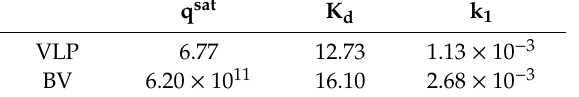
Table 1. Best-fit values of the kinetic form of the Langmuir adsorption isotherm. The